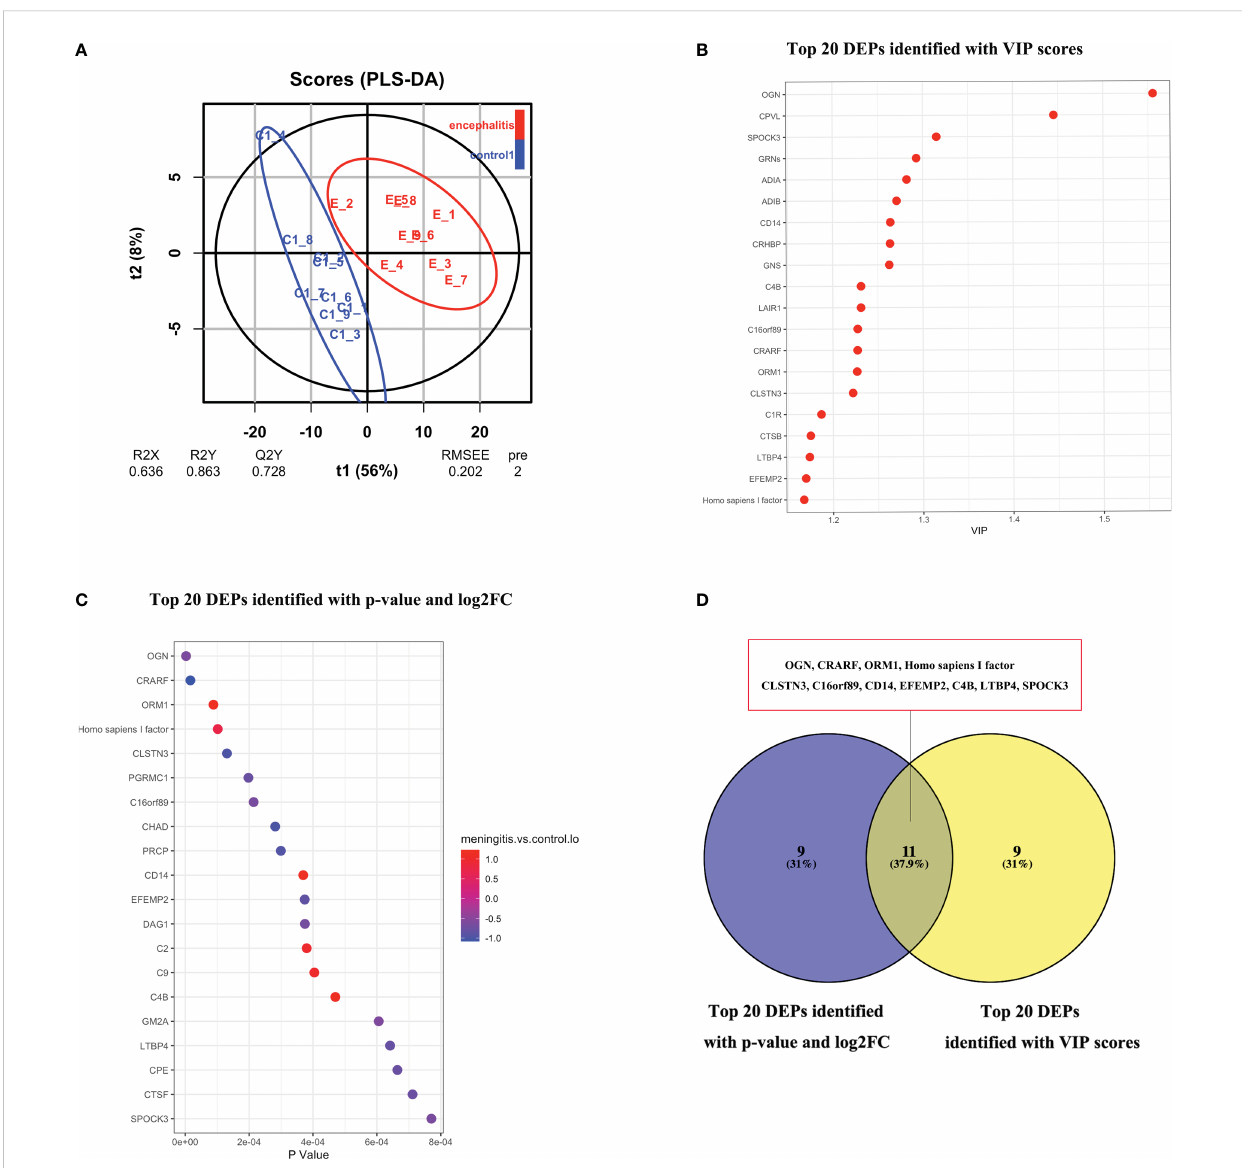
FIGURE 3 (A) O-PLS-DA analysis of DEPs between children with with HEV-positive meningitis and normal controls. (B) Top 20 DEPs identi fi ed with most importance using O-PLS-DA. (C) Top 20 DEPs identi fi ed with P value and FC. (D) 11 DEPs identi fi ed with top-ranked P value, FC and VIP